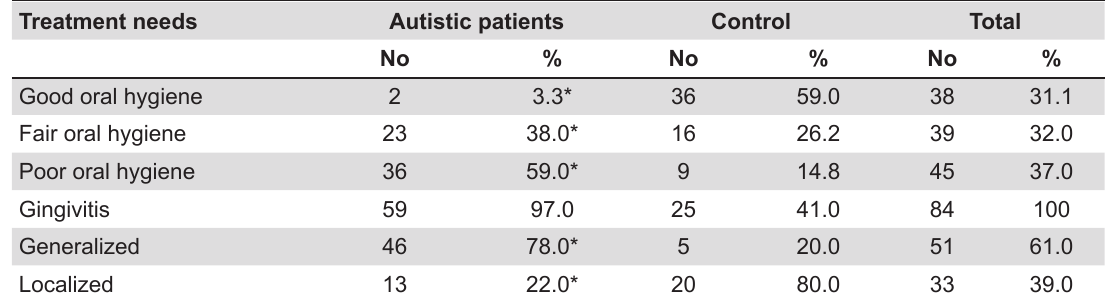
*p<0.05 as compared to the control group Table 4- Oral hygiene and gingival status of the 61 autistic patients and 61 healthy control